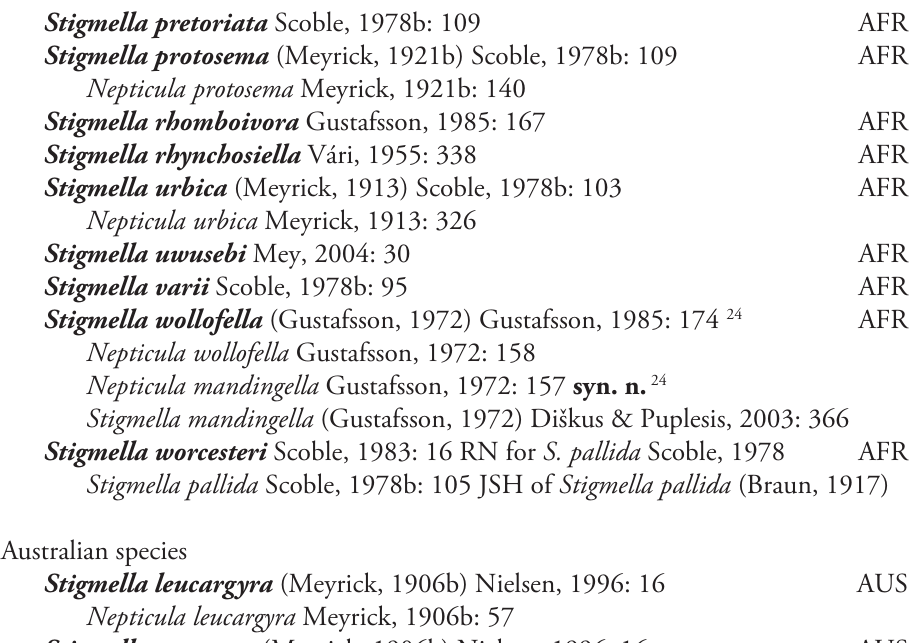
Stigmella pretoriata Scoble, 1978b: 109 AFR Stigmella protosema (Meyrick, 1921b) Scoble, 1978b: 109 AFR Nepticula protosema Meyrick, 1921b: 140 Stigmella rhomboivora Gustafsson, 1985: 167 AFR Stigmella rhynchosiella Vári, 1955: 338 AFR Stigmella urbica (Meyrick, 1913) Scoble, 1978b: 103 AFR Nepticula urbica Meyrick, 1913: 326 Stigmella uwusebi Mey, 2004: 30 AFR Stigmella varii Scoble, 1978b: 95 AFR Stigmella wollofella (Gustafsson, 1972) Gustafsson, 1985: 174 24 AFR